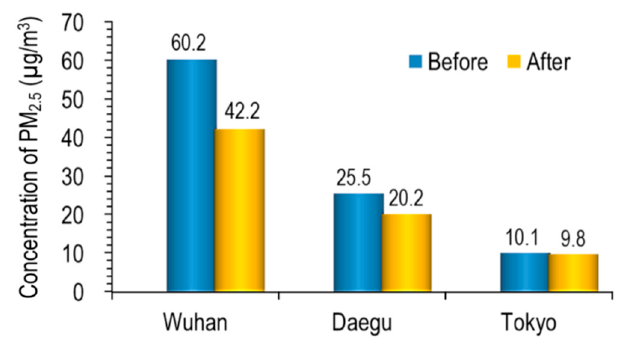
Figure 5. Comparison of PM 2.5 concentration before and after each city’s self-reflection.